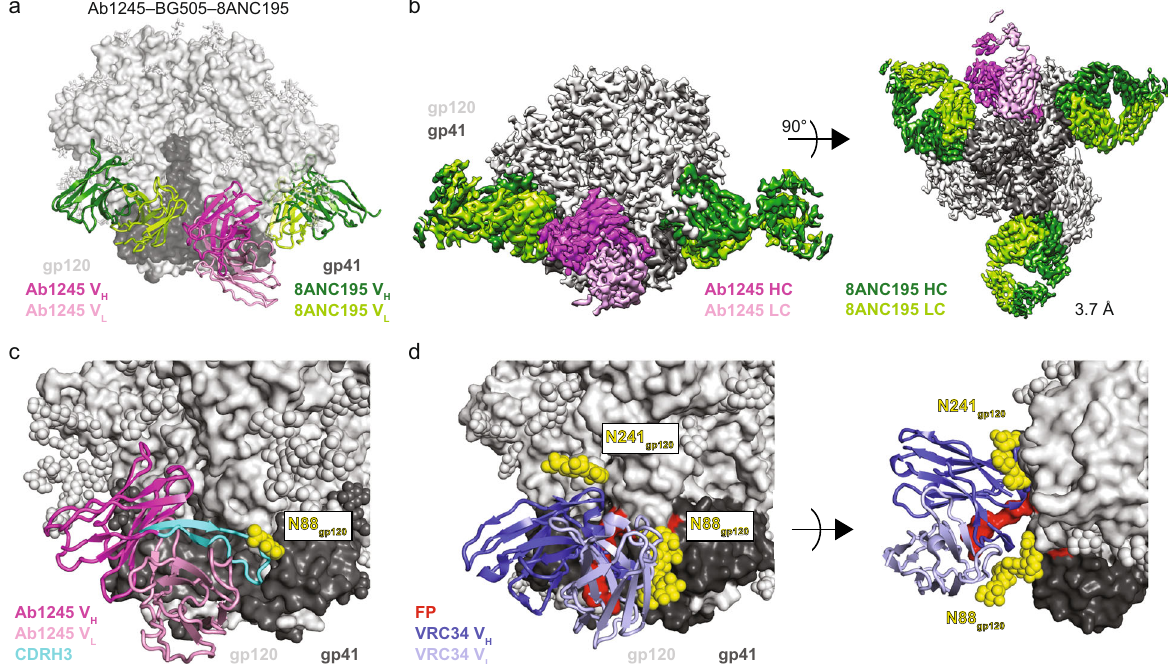
Fig. 2 Ab1245 binds the gp120-gp41 interface. a Representation of Ab1245-BG505-8ANC195 structure. Fabs are shown in cartoon, BG505 is shown as surface, and glycans are shown as sticks. Within BG505, gp120 is light gray and gp41 is dark gray. The Ab1245 V H -V L is dark pink (heavy chain) and light pink (light chain); 8ANC195 Fabs are dark green (heavy chain) and light green (light chain). b Side view (left) and view looking up from the trimer base (right) of density map for 3.7 Å Ab1245-BG505-8ANC195 complex. Colors as in ( a ). c Close-up view of Ab1245 V H -V L domains (cartoon) interacting with gp120-gp41 interface with highlighted CDRH3 (cyan). N-linked glycans are light gray (gp120), dark gray (gp41), or yellow (N88 gp120 and N241 gp120 glycans) spheres. d Cartoon representation of VRC34-AMC011 SOSIP structure (PDB 6NC3) from the same view as c (left) and a different view from above the trimer (right). VRC34 heavy and light chains (PDB 6NC3) are dark and light purple,